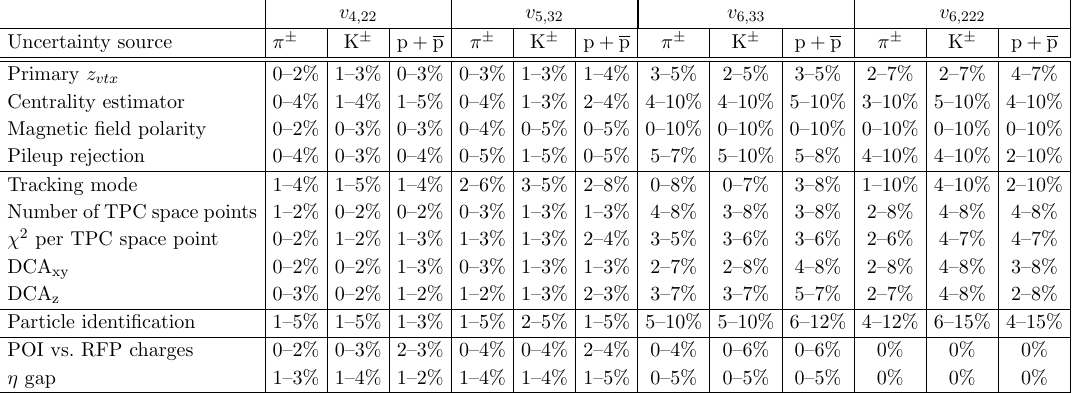
Table 1 . List of the maximum relative systematic uncertainties of each individual source for v n ; mk of (cid:25) (cid:6) , K (cid:6) and p + p. The uncertainties depend on the transverse momenta. Percentage ranges are given to account for all centrality